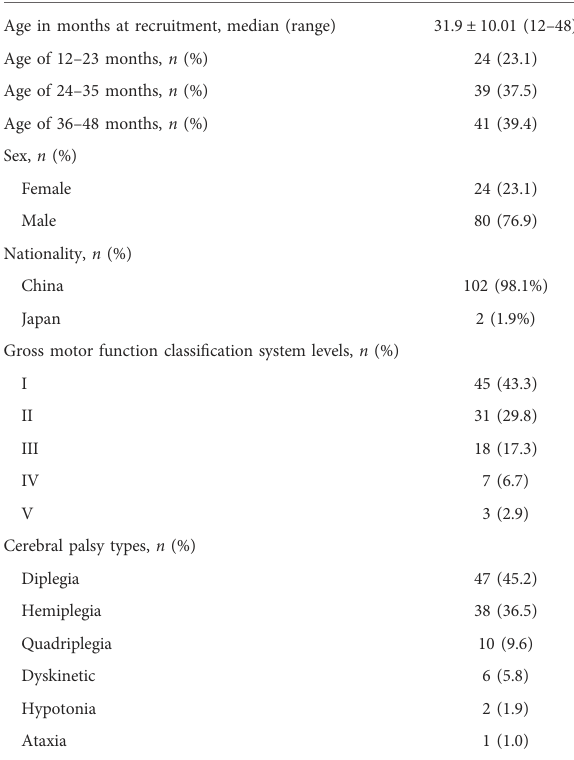
TABLE 1 Demographic data of the participants ( n